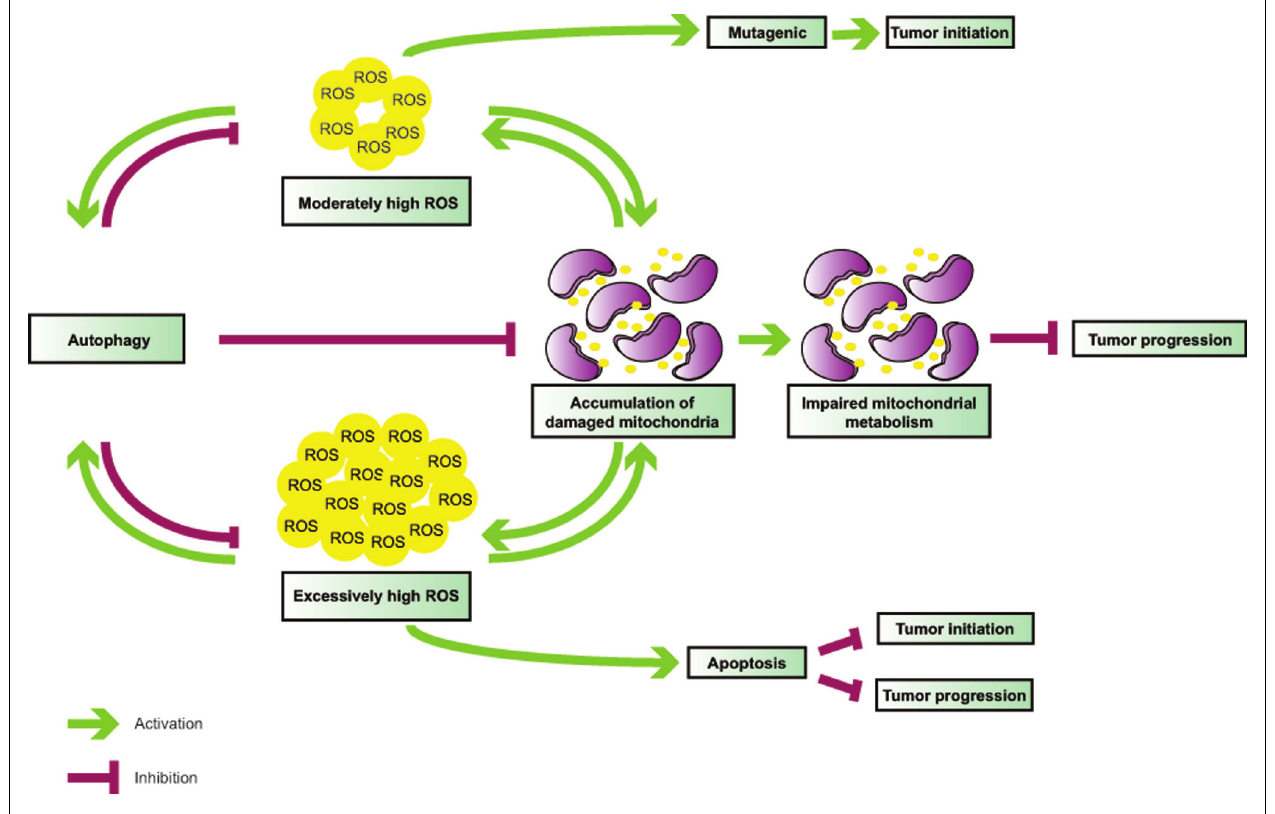
thereby creating a vicious cycle.While moderately high ROS levels are mutagenic and likely mediate tumor initiation in association with autophagy defects, very high ROS levels may result in apoptosis, and, thus, inhibit both tumor initiation and progression.